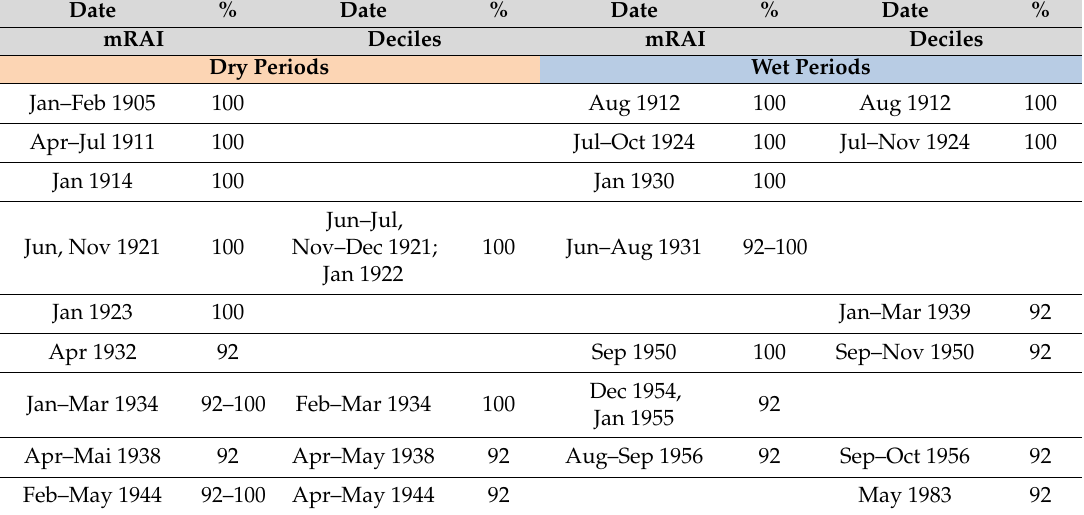
Table A1. Sub-region British Isles—overview on the TOP20 months with the highest spatial extent of dry and wet periods within the study period